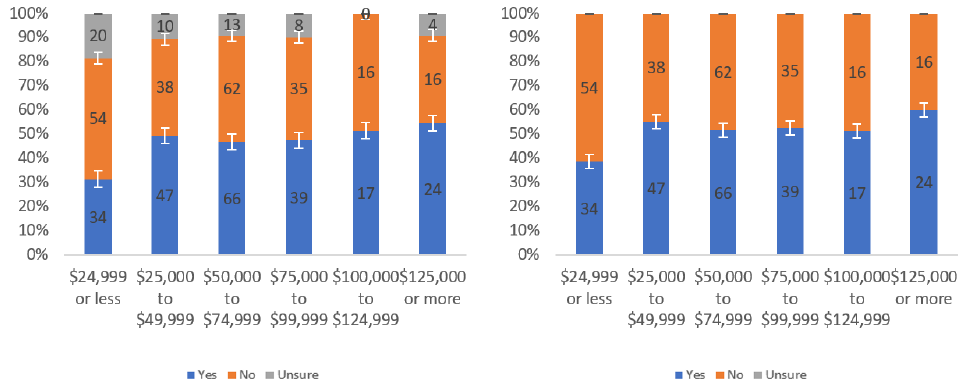
Figure A19. Responses regarding label annoyingness by income level including ( left ) and excluding ( right ) unsure responses.